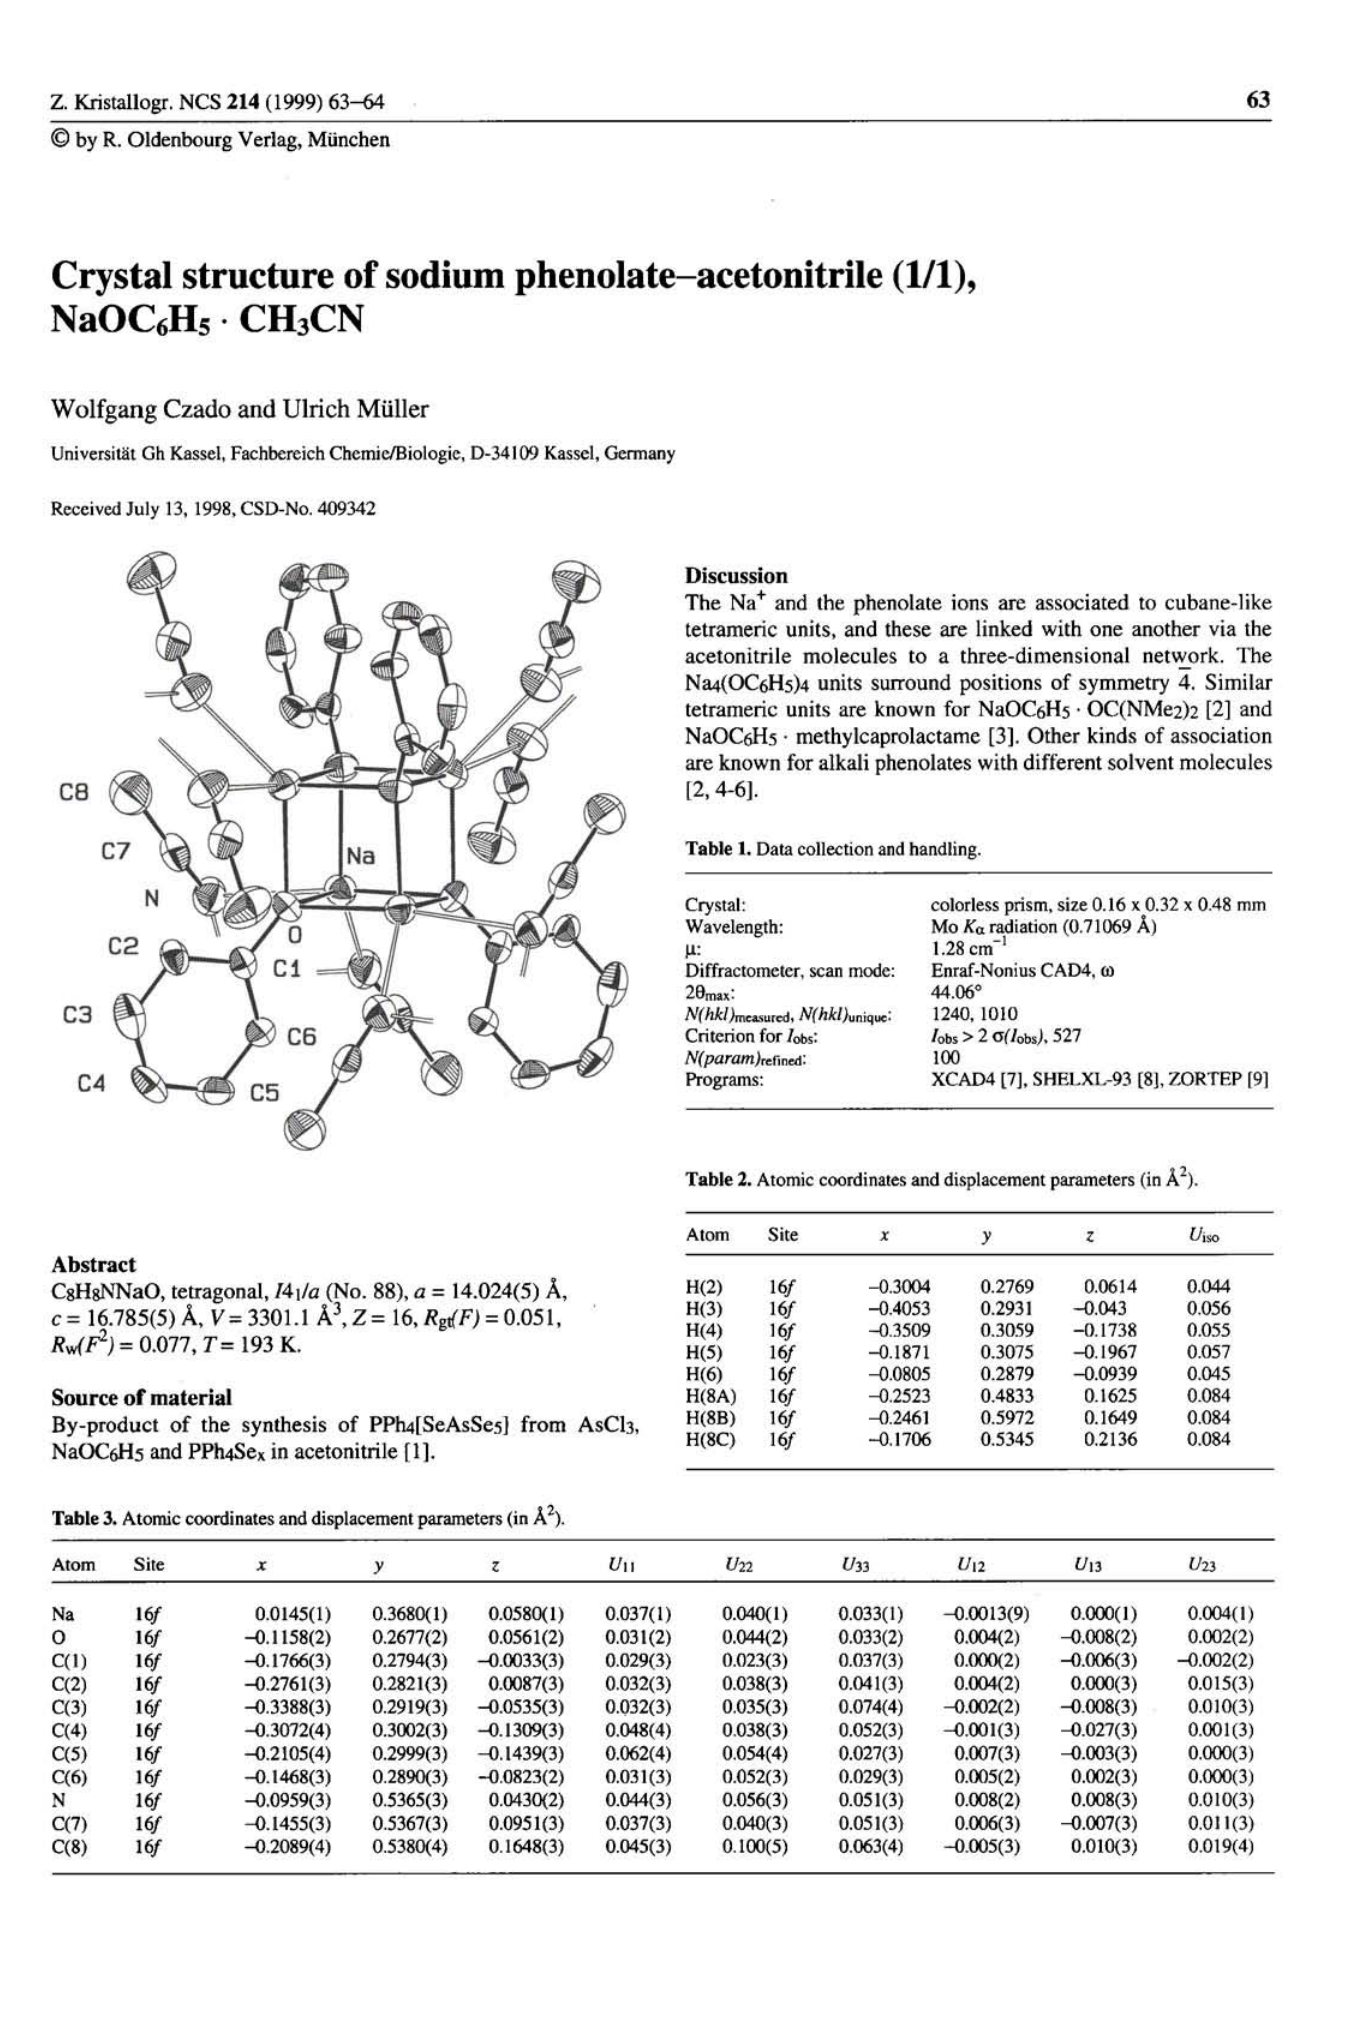
Table 3. Atomic coordinates and displacement parameters (in Â 2